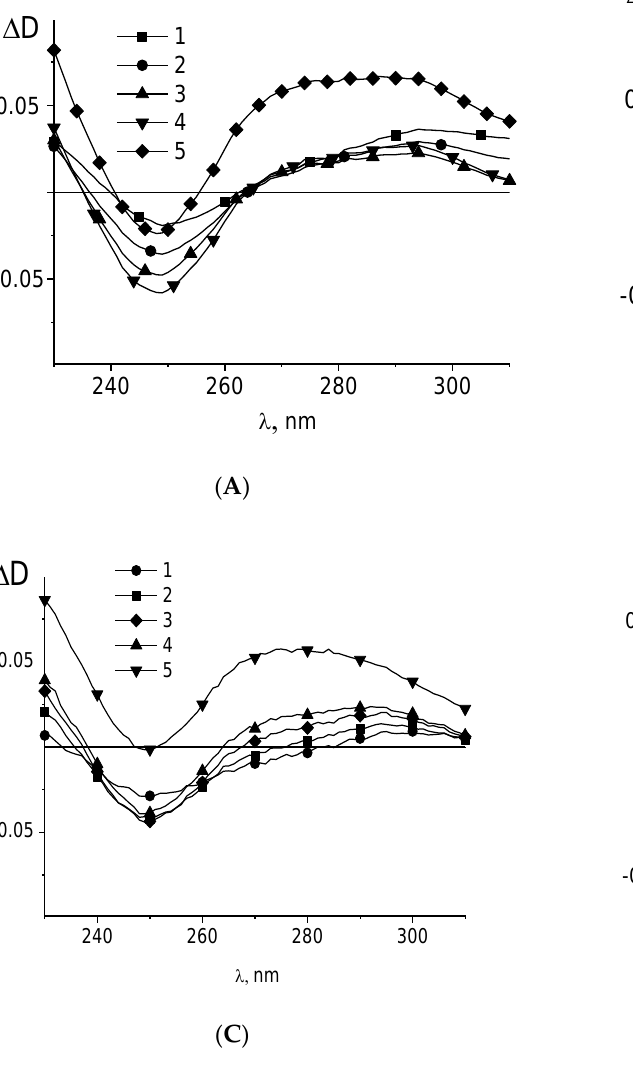
Figure 3. Differential absorption spectra (calculated absorption of DNA in complexes minus absorp- tion of free DNA) for DNA complexes in 0,005 M NaCl with cis-DDP ( A ) at C(Pt) × 10 5 = 1.2 (1). 2.2 (2), 3.9 (3), 4.1 (4), 5.6 (5); for DNA complexes with Pt2 ( B ) at C(Pt2) × 10 5 =